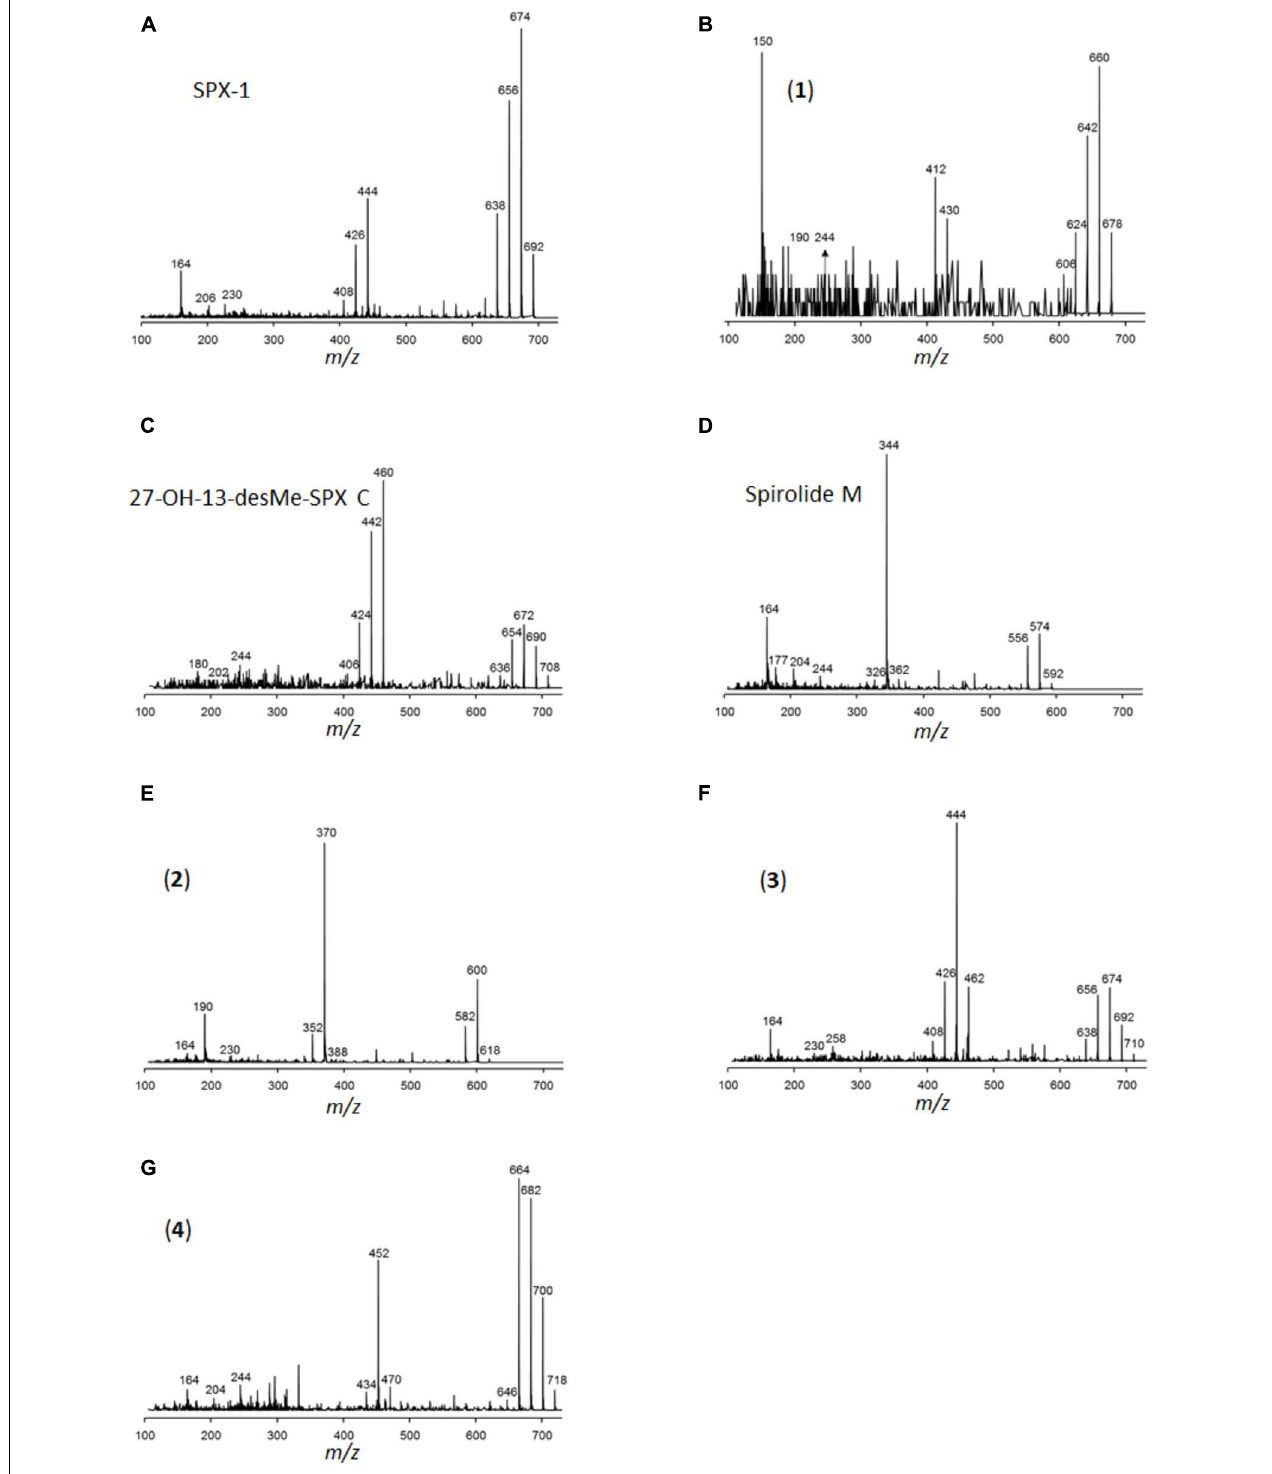
FIGURE 12 | Collision-induced dissociation (CID) spectra of the spirolides detected in A. ostenfeldii : (A) SPX-1 (13-desMethyl-spirolide C), identical with spectrum shown in Sleno and Volmer (2005), (B) 13/19,31-didesMethyl-spirolide C, (C) 27-Hydroxy-13-desMethyl-spirolide C, (D) Spirolide M, (E) compound 2, (F) compound 3, and (G) compound